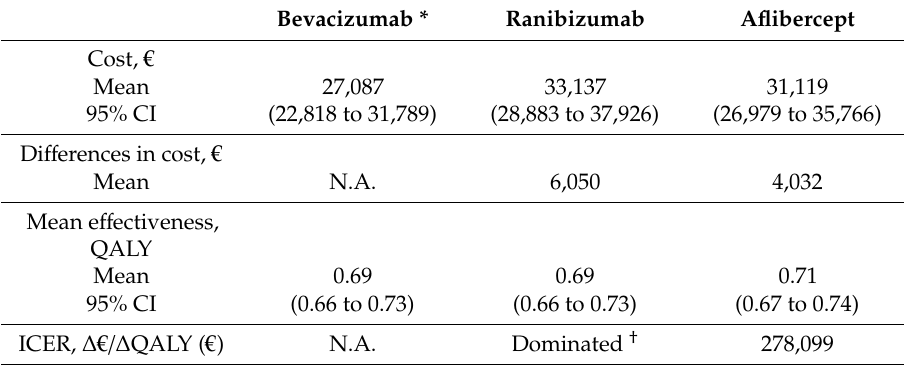
Table 8. Di ff erences in e ff ectiveness and costs between vascular endothelial growth factor inhibitors (anti-VEGF), per patient during the first year of treatment. Adapted from van Asten et al.